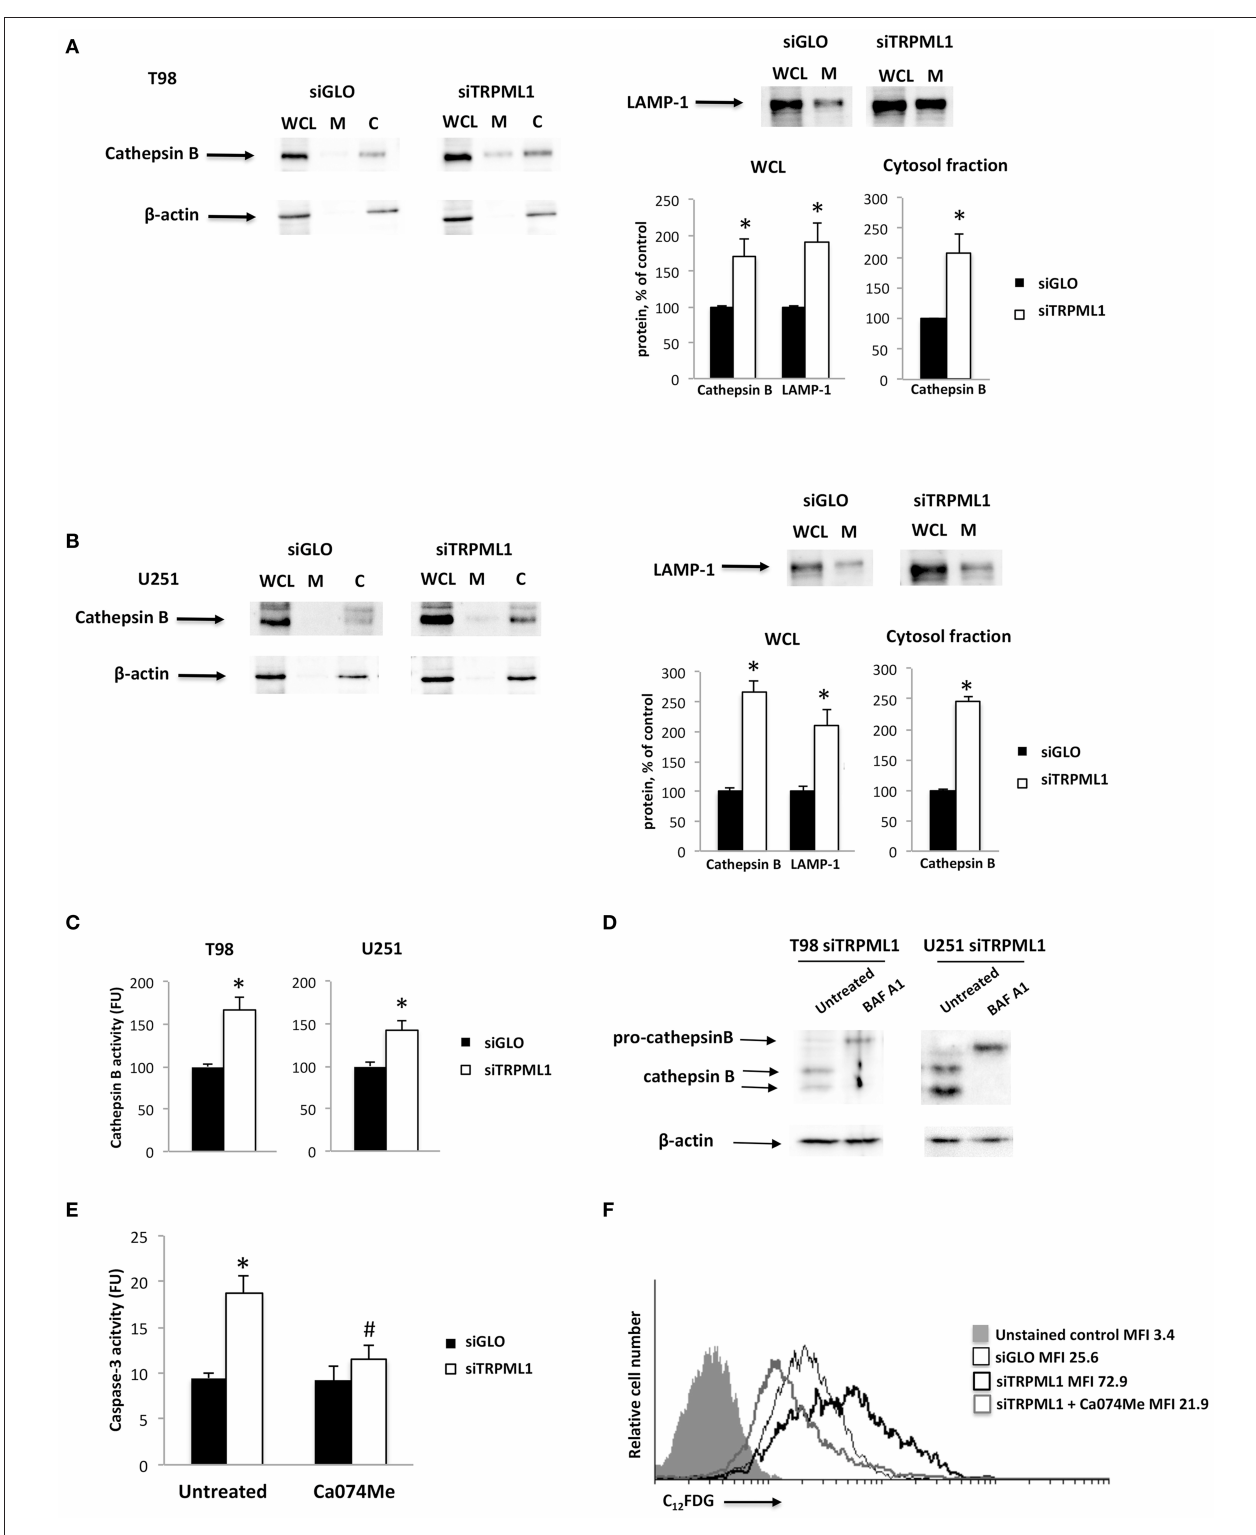
FIGURE 6 | Transient receptor potential mucolipin 1 (TRPML1) silencing induces cathepsin B activation. (A) Whole cell lysate (WCL), membrane (M), and cytosolic (C) fractions were isolated from siGLO and siTRPML1 T98 cells. (B) WCL, M, and C fractions were isolated from siGLO and siTRPML1 T98 cells. Cathepsin B and